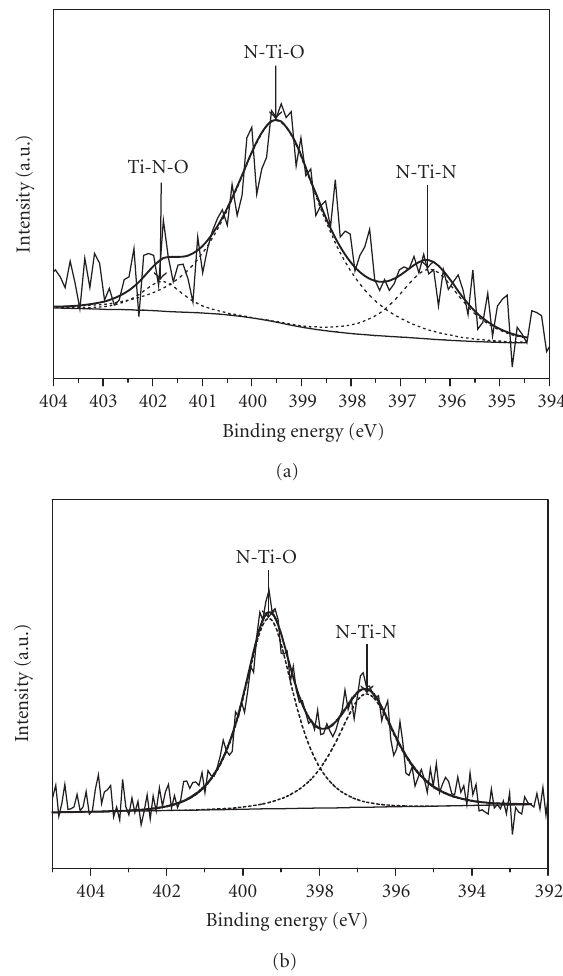
Figure 5: (a) N 1s core-level spectrum (deconvolution of N 1s bands) of TDN. (b) N 1s core-level spectrum (deconvolution of N 1s bands) of